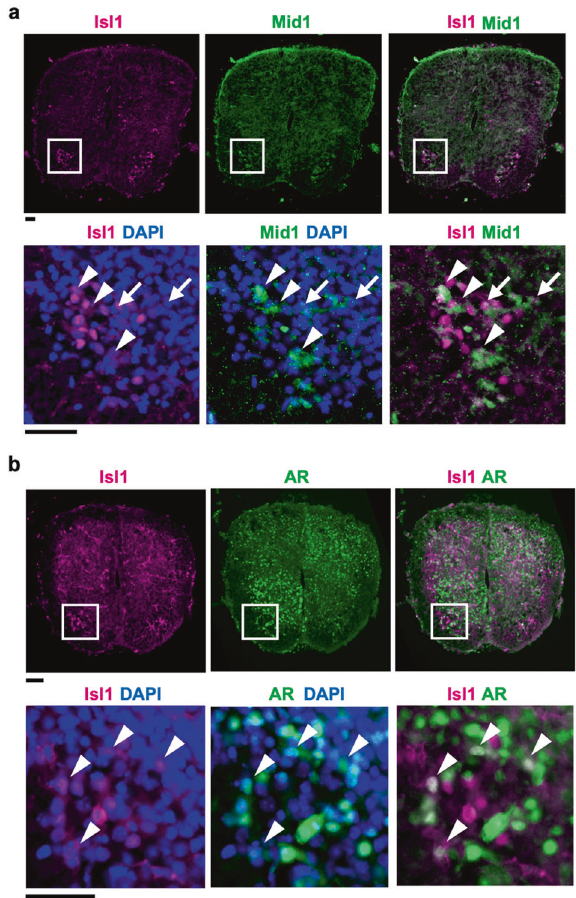
Fig. 3 Expression of Mid1 in the developing spinal motor neurons of SBMA mice. a Immunostaining of Mid1 and Isl1 in the fetal mouse spinal cord. The anterior (ventral) side is toward the bottom. Boxed regions in the upper panels were magni fi ed in the lower panels. Arrowheads and arrows indicate the overlap of strong and weak Mid1 expression with Isl1 expression, respectively. b Immunostaining of human AR and Isl1 in the fetal mouse spinal cord. Arrowheads indicate the overlap of nuclear AR and Isl1 expression. Scale bars 50 μ